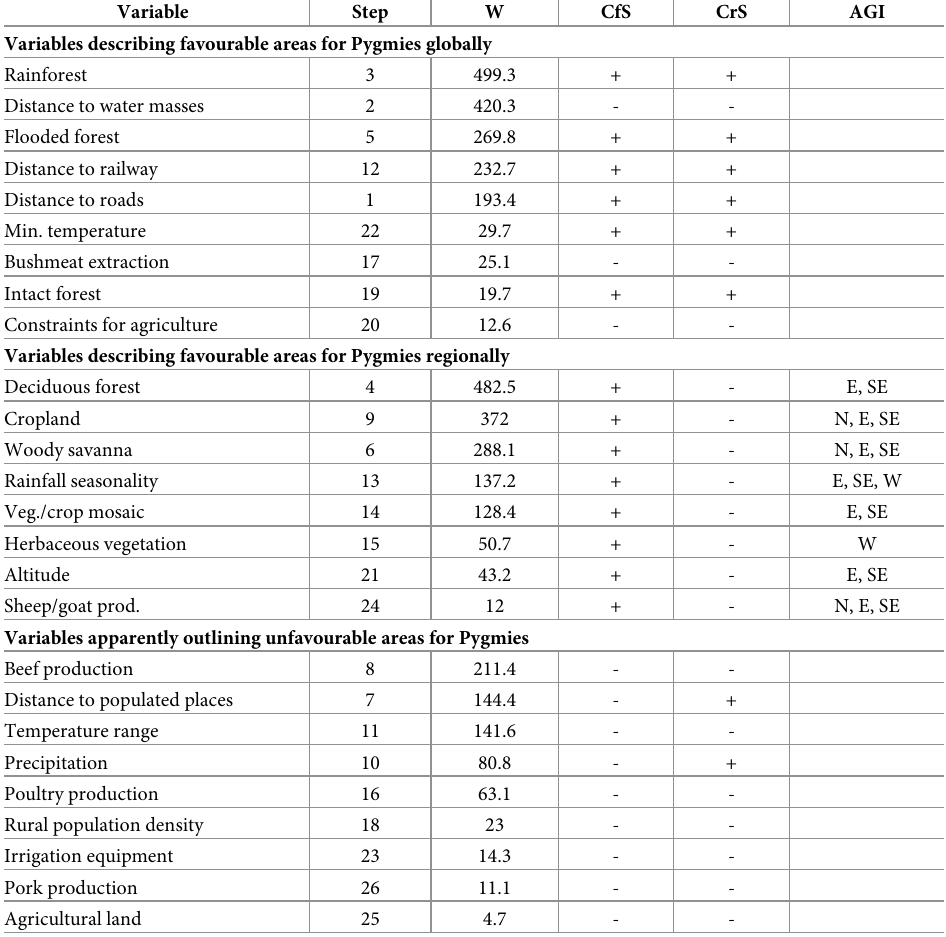
Table 1. Descriptor variables of the environmentally favourable areas for Pygmies according to the favourability model. Step: Order or entrance in the model; W: Univariate Wald test statistic quantifying variable significance in the model (all the variables shown were significant with P < 0.05); CfS: Sign of the variable coefficient in the model; CrS: Sign of the correlation (Spearman) between the variable and favourability values; AGI: Area of geographic influence of the variable in the model within the Central African study area (N = North, S = South, E = East, SE = South-East, W = West). Variable